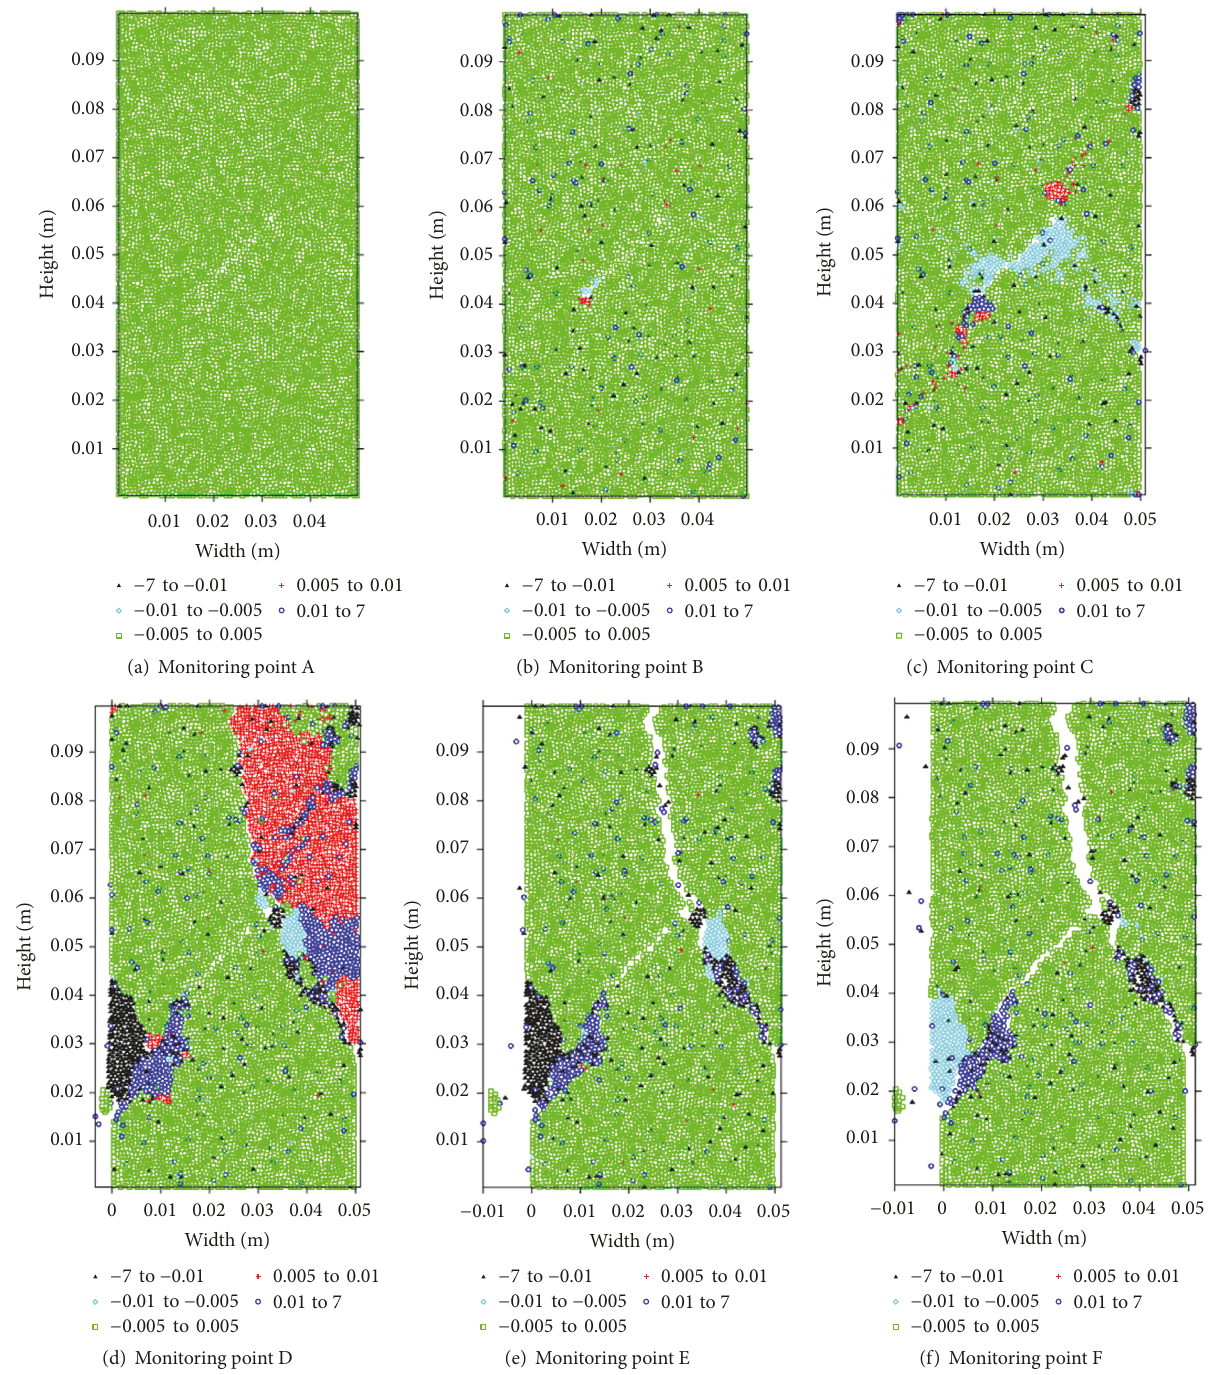
Figure 13: Evolution of particle rotation angle in the